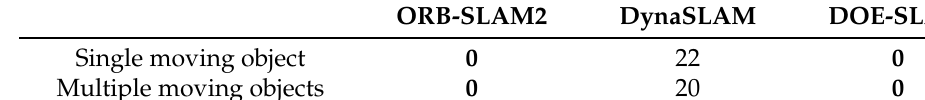
Table 7. Comparison of the number of lost tracking frames.